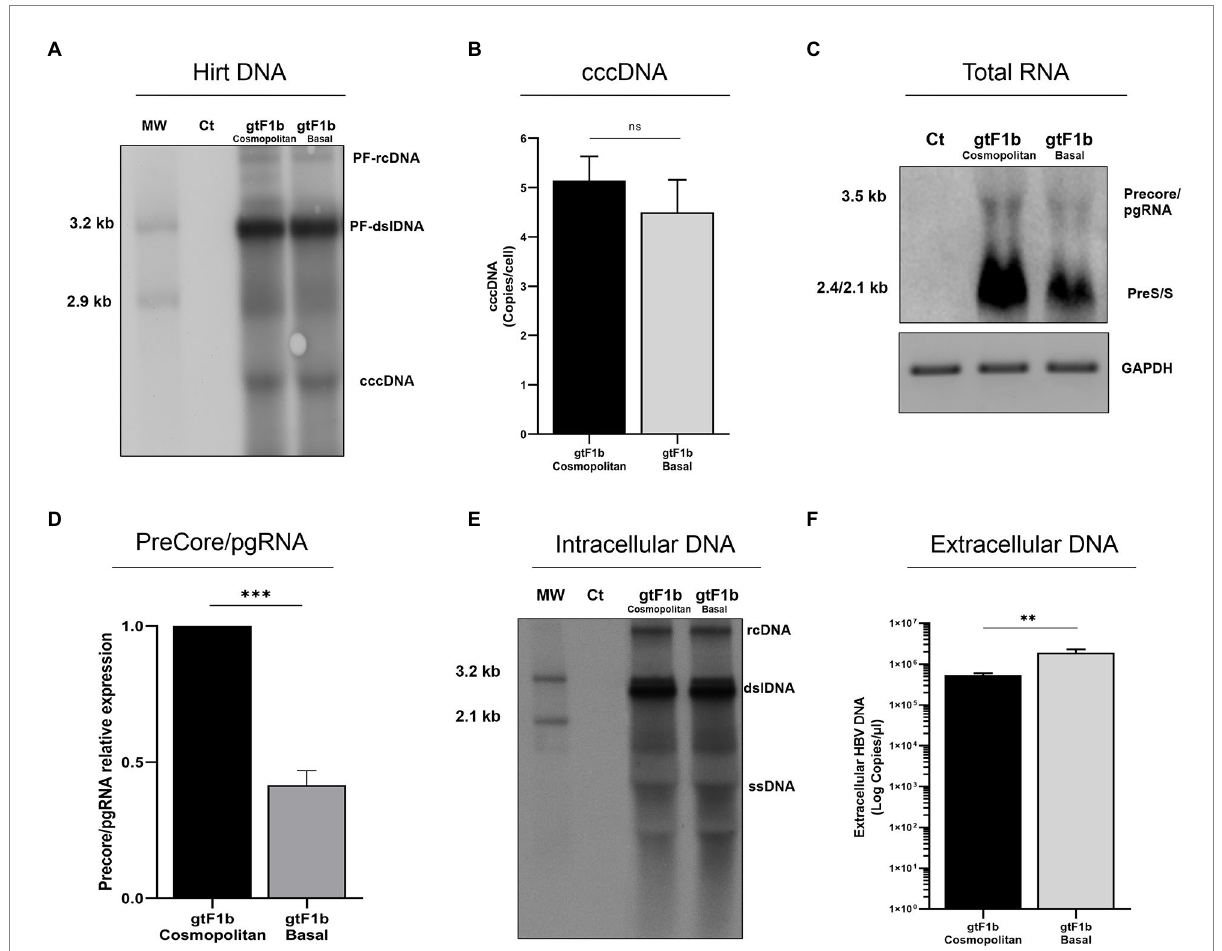
FIGURE 3 Analysis of HBV replicative capacity between gtF1b Cosmopolitan and gtF1b Basal variants. HuH-7 cells were transfected with linear full-length HBV genomes of gtF1b Cosmopolitan and gtF1b Basal variants and three days’ post-transfection cells and supernatants were harvested. (A) DNA was isolated after Hirt extraction and subjected to Southern blot analysis. (B) Total DNA was extracted, treated with T5 exonuclease to remove non-supercoiled dsDNA, and cccDNA levels were assessed by qPCR. Results were normalized to mitochondrial DNA. (C) Total RNA was extracted, and HBV RNA was detected by Northern blot. GAPDH RNA served as loading control. (D) Relative intensity of the Precore/pgRNA band was quantified using ImageJ software. (E) Cytoplasmic DNA was extracted HBV DNA replicative intermediates were assessed by Southern blot. (F) Extracellular HBV DNA was quantified by qPCR. PF-rcDNA: protein free HBV relaxed circular DNA; PF-dslDNA: protein free HBV double- stranded linear DNA. rcDNA: HBV relaxed circular DNA; dsLDNA: HBV double-stranded linear DNA; SS: HBV single-stranded DNA. Shown